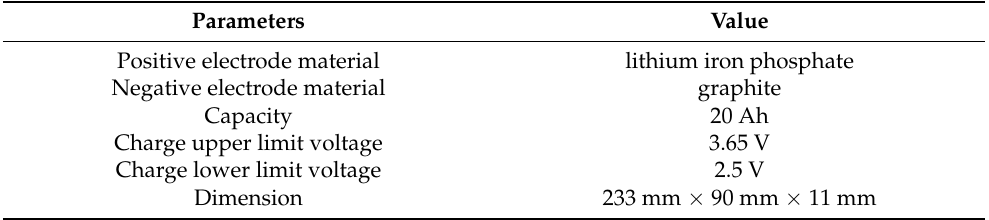
Table 4. Experimental battery